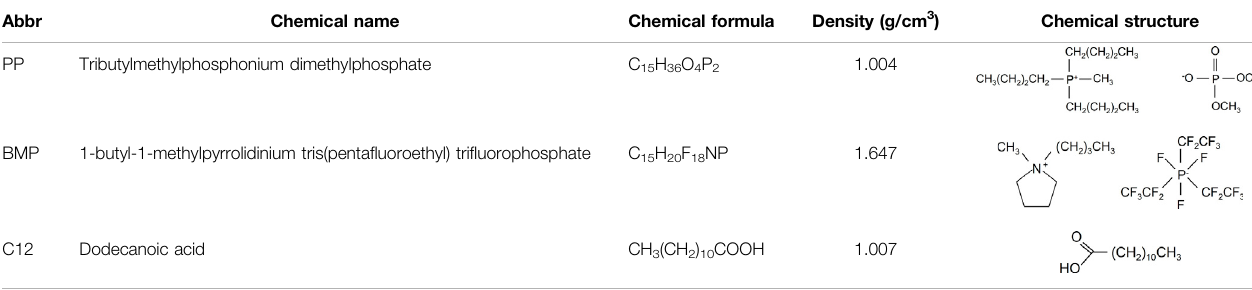
TABLE 1 | Chemical formula, density, and chemical structure of all